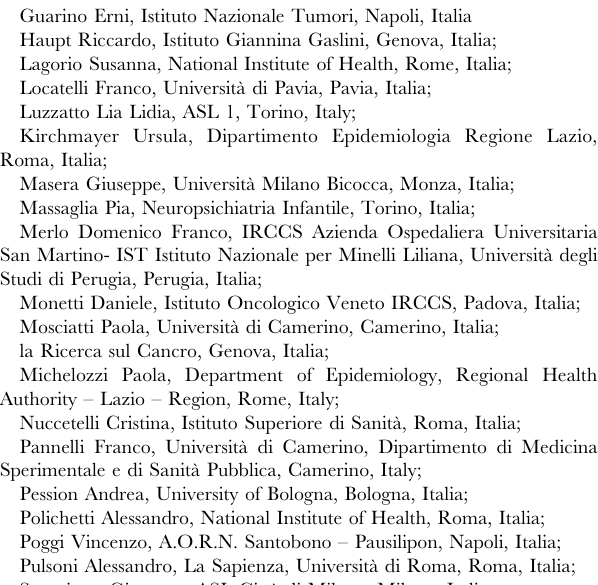
Table S1 Studies on Paternal Tobacco Smoking and Risk of Childhood Acute non-Lymphocytic